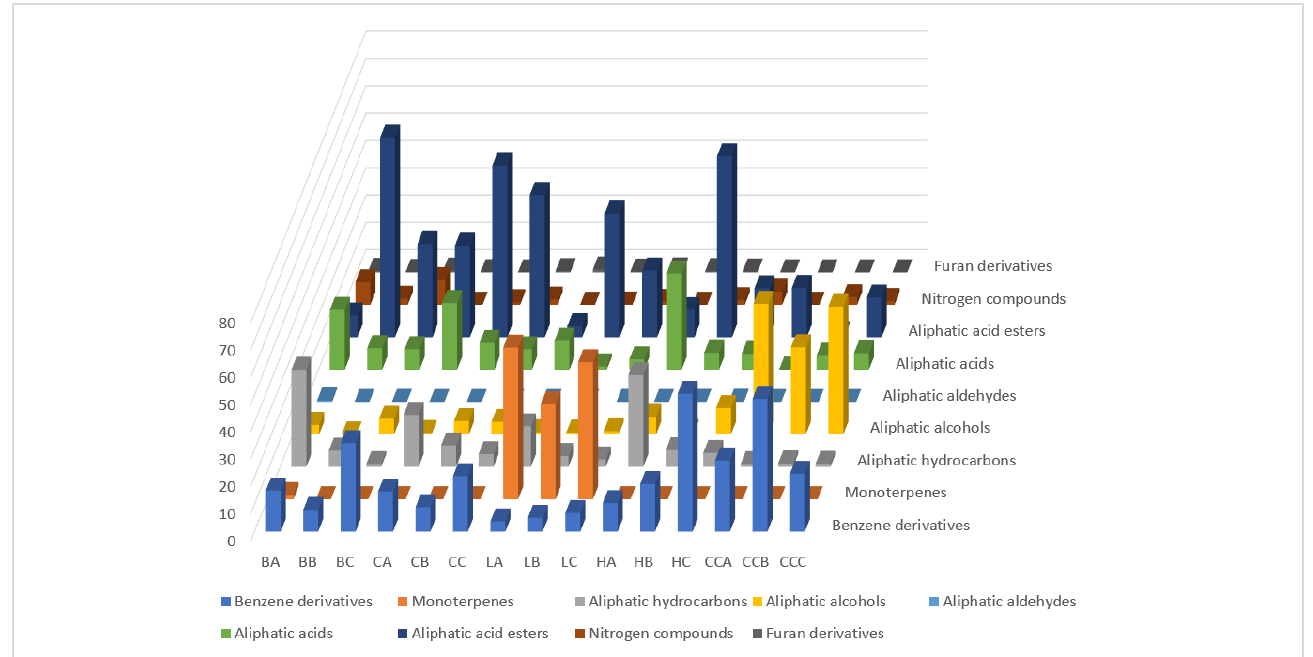
Figure 3. The overall percentages of the different volatile organic compound (VOC) structural groups in the analyzed honeys and meads by DHLLE. BA, BB, BC—buckwheat honey, not boiled and boiled mead, respectively; CA, CB, CC—canola honey, not boiled and boiled mead, respectively; LA, LB, LC—lime tree honey, not boiled and boiled mead, respectively; HA, HB, HC—honeydew honey, not boiled and boiled mead, respectively; CCA, CCB, CCC— glucose–fructose syrup, not boiled and boiled mead, respectively.